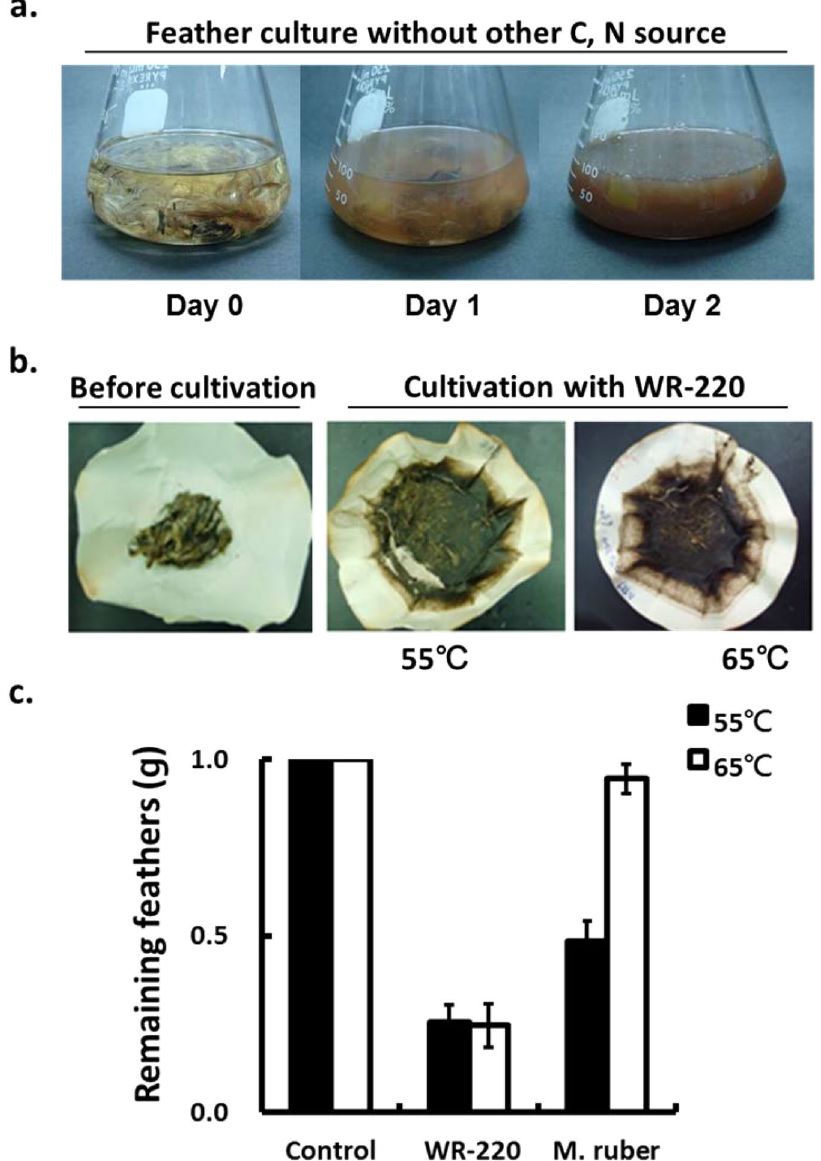
Figure 1. Degradation of intact chicken feathers by M. taiwanensis WR-220. ( a ) M. taiwanensis WR-220 degraded native chicken feathers at 55 °C after two days of incubation. The basal medium contained 0.5% feathers (w/v) as the sole source of carbon and nitrogen. ( b ) The remaining feathers after decay in two days culture at 55 and 65 °C were shown on filter papers. ( c ) M. taiwanensis WR-220 displayed high feather- degrading activity at 55 and 65 °C compared to the Meiothermus species, M. ruber . Feather-degrading capacity was determined by the weight of feathers remaining in the cultures medium containing 1% feathers (w/v) as only carbon and nitrogen source. All results were calculated from three independent experiments. Control was a non-inoculated